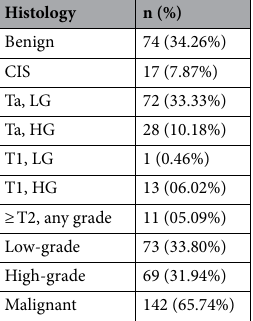
Table 1. Distribution of pathological staging after TUR-BT of the respective PDD positive lesions. The separation into low-grad and high-grade was made according to the WHO 2004 classification and malignant was defined as all samples diagnosed with any kind of bladder